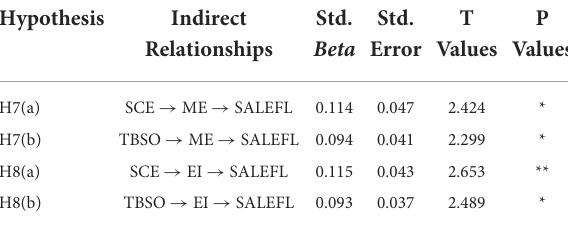
TABLE 6 Hypotheses testing mediation